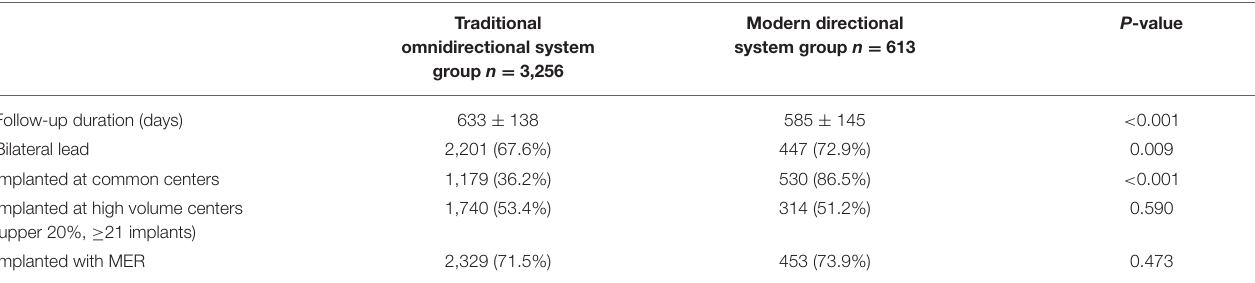
TABLE 3 | Implant characteristics for the traditional omnidirectional subgroup and the modern directional